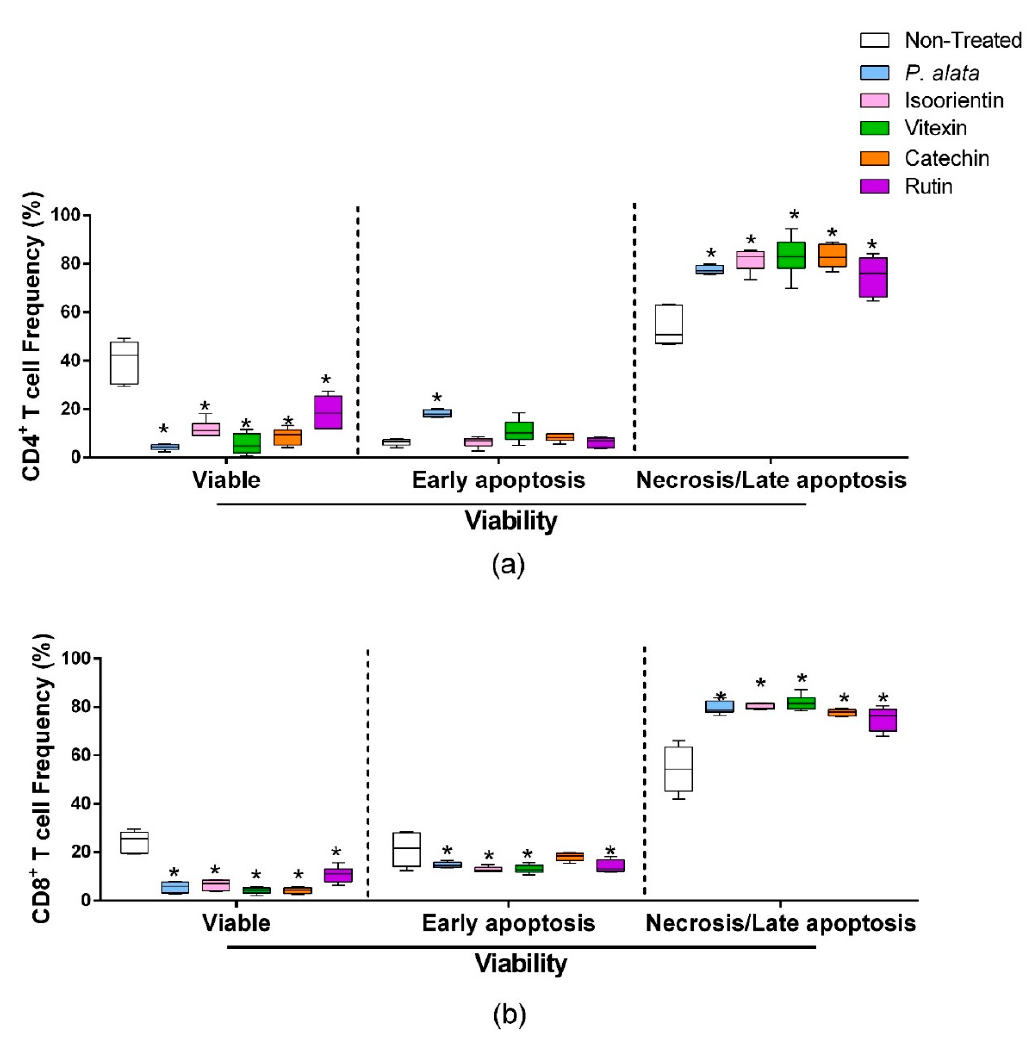
Figure 4. Effect of P. alata extract and polyphenols on viability and mitochondrial membrane potential. The boxplots represent the frequency of viable (left), early apoptosis (middle) and necrosis or late apoptosis (right) of CD4 + ( a ) and CD8 + ( b ) T cells stimulated with ConA and cultured in the presence of IC 50 doses of P. alata extract, isoorientin, vitexin, catechin and rutin (colored boxplot). The cultures were treated with PBS only (non-treated, white boxplot) as a control: * p ≤ 0.05 compared to the non-treated group; n = 6 with triplicate cell